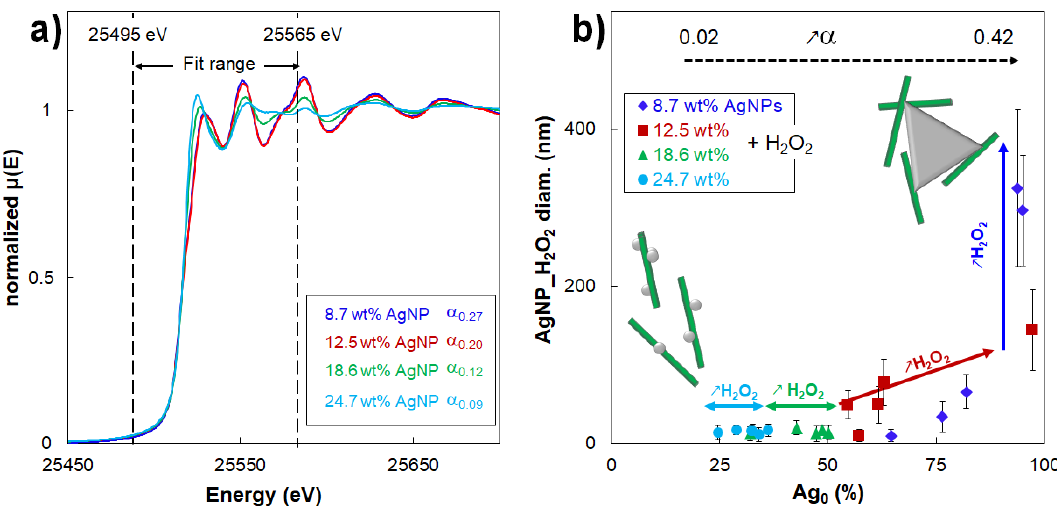
Figure 4. ( a ) XANES spectra of hybrids at different initial AgNP content treated with 160 µL of H 2 O 2 (i.e., α values above and below critical value of 0.20) ( b ) evolution of the average diameter of AgNPs_H 2 O 2 in CNC / AgNP_H 2 O 2 hybrids as a function of their Ag 0 content estimated from XANES spectra.